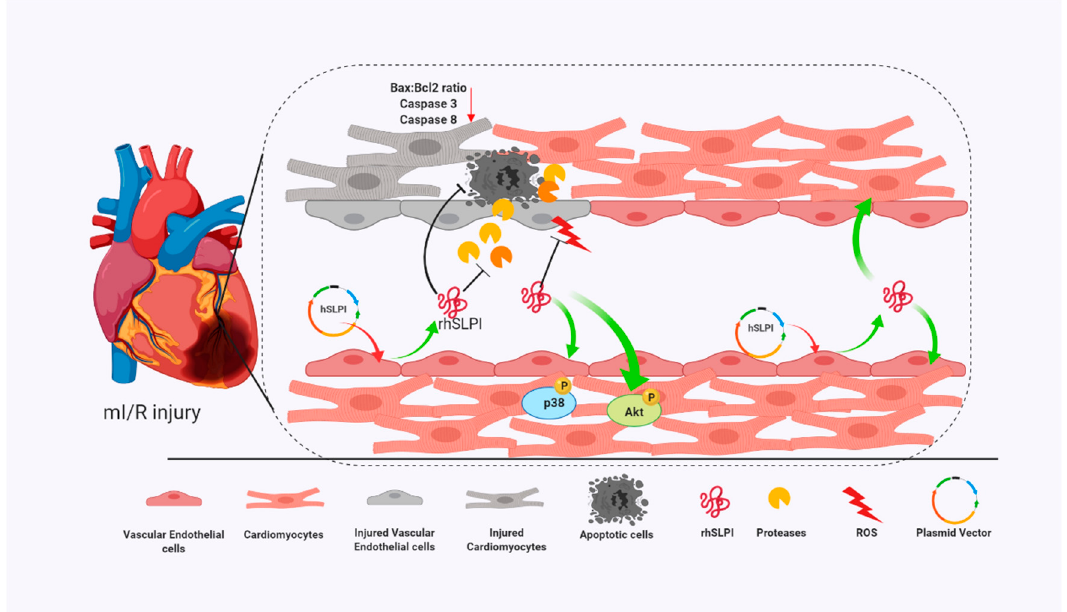
Figure 9. A schematic diagram of the major findings in this study. The rhSLPI that was overexpressed and secreted from vascular endothelial cells could protect not only endothelial cells but also cardiomyocytes from I/R injury. The mechanisms for this could be due to the attenuation of intracellular ROS production, activation of Akt and p38 MAPK phosphorylation, and reduction of apoptotic regulatory proteins (Bcl-2, caspase-3, caspase-8).